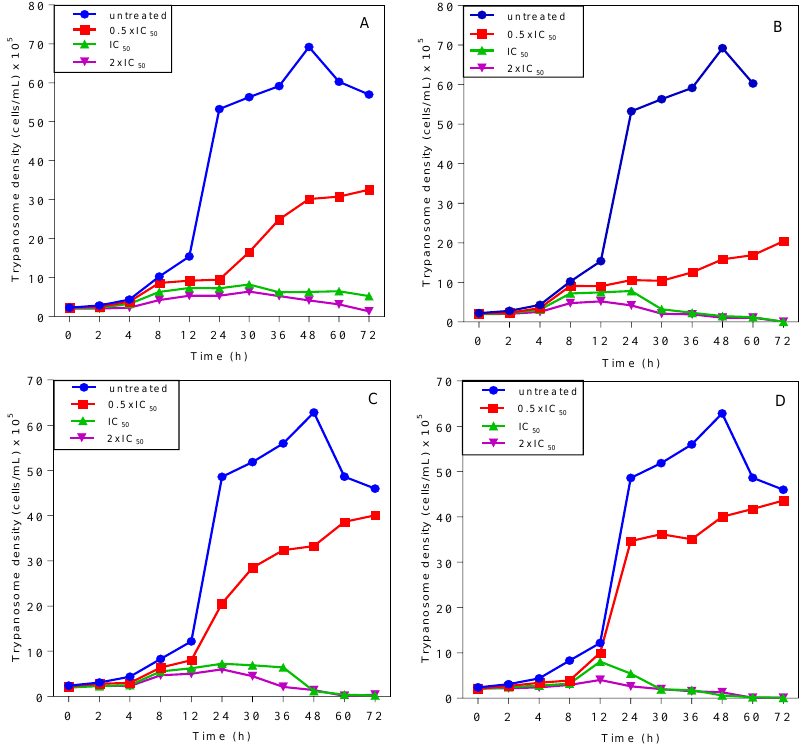
Figure 1. Growth curves of wild-type T. b. brucei grown in the continuous presence of 1 ( A ) or 2 ( B ) and in Hirumi’s modified Iscove’s medium (HMI-9) standard growth media after a short incubation period (2 h) with 1 ( C ) or 2 ( D